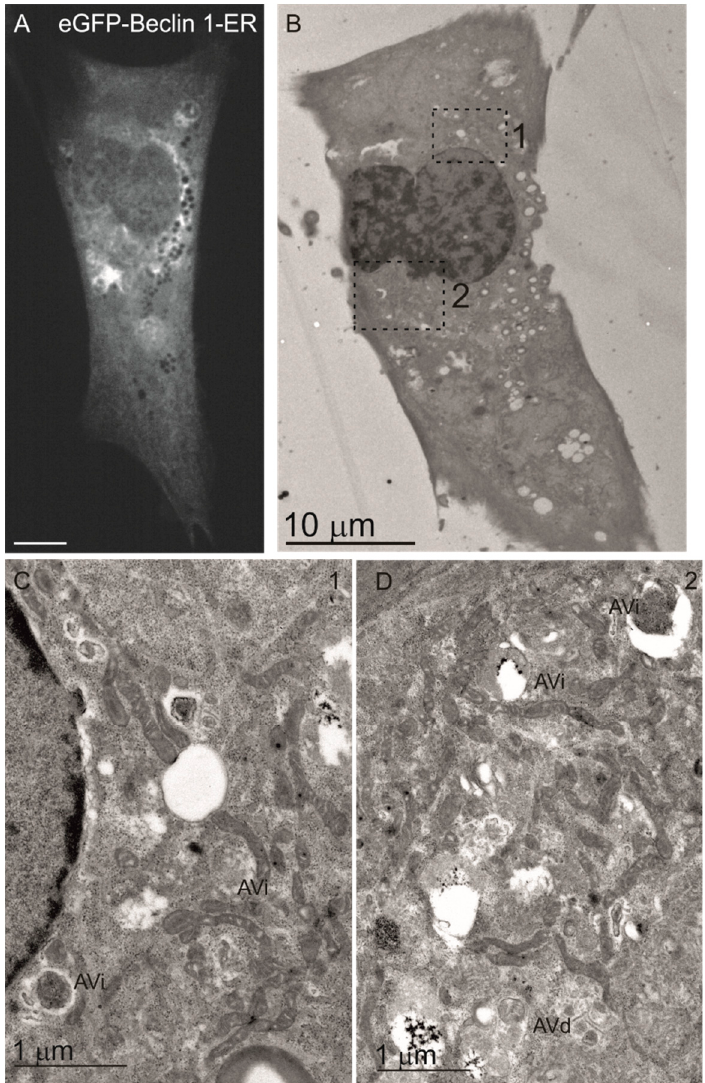
Figure 8. Electron microscopy analysis of ULK1/2-KO MEFs expressing eGFP-Beclin 1-ER. The cells were transfected with eGFP-Beclin 1-ER and starved in amino-acid free medium for 1 h before fixation. ( A ) Confocal image of a cell expressing eGFP-Beclin 1-ER. Scale bar, 10 μ m. ( B ) Electron micrograph of the same cell. ( C – D ) Higher magnification images of boxed areas in B, showing normal morphology of AVi (initial autophagic vacuoles/autophagosomes) and AVd (degradative autophagic vacuoles).